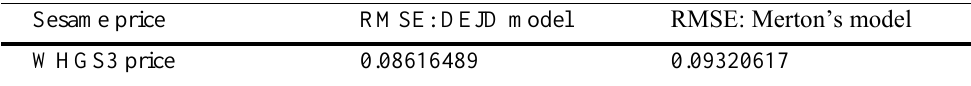
Table 4. RMSE values under DEJD and Merton’s